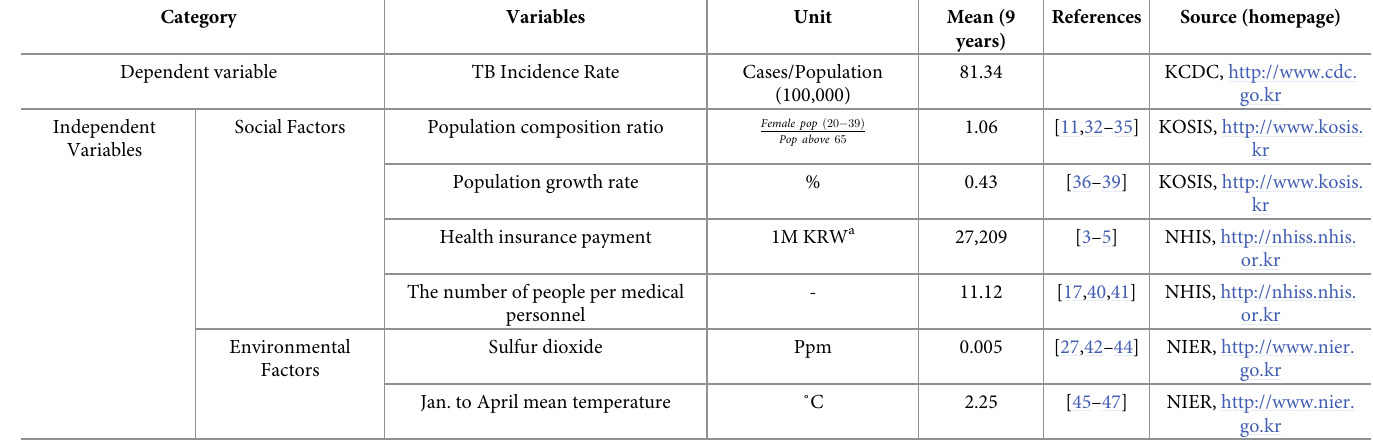
Table 1. Descriptive statistics and references for the